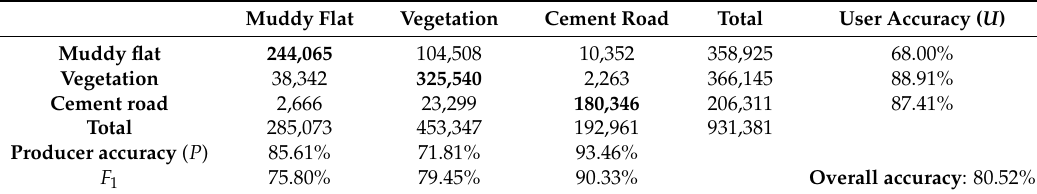
Table 8. Confusion matrix of classification by final corrected intensity data.